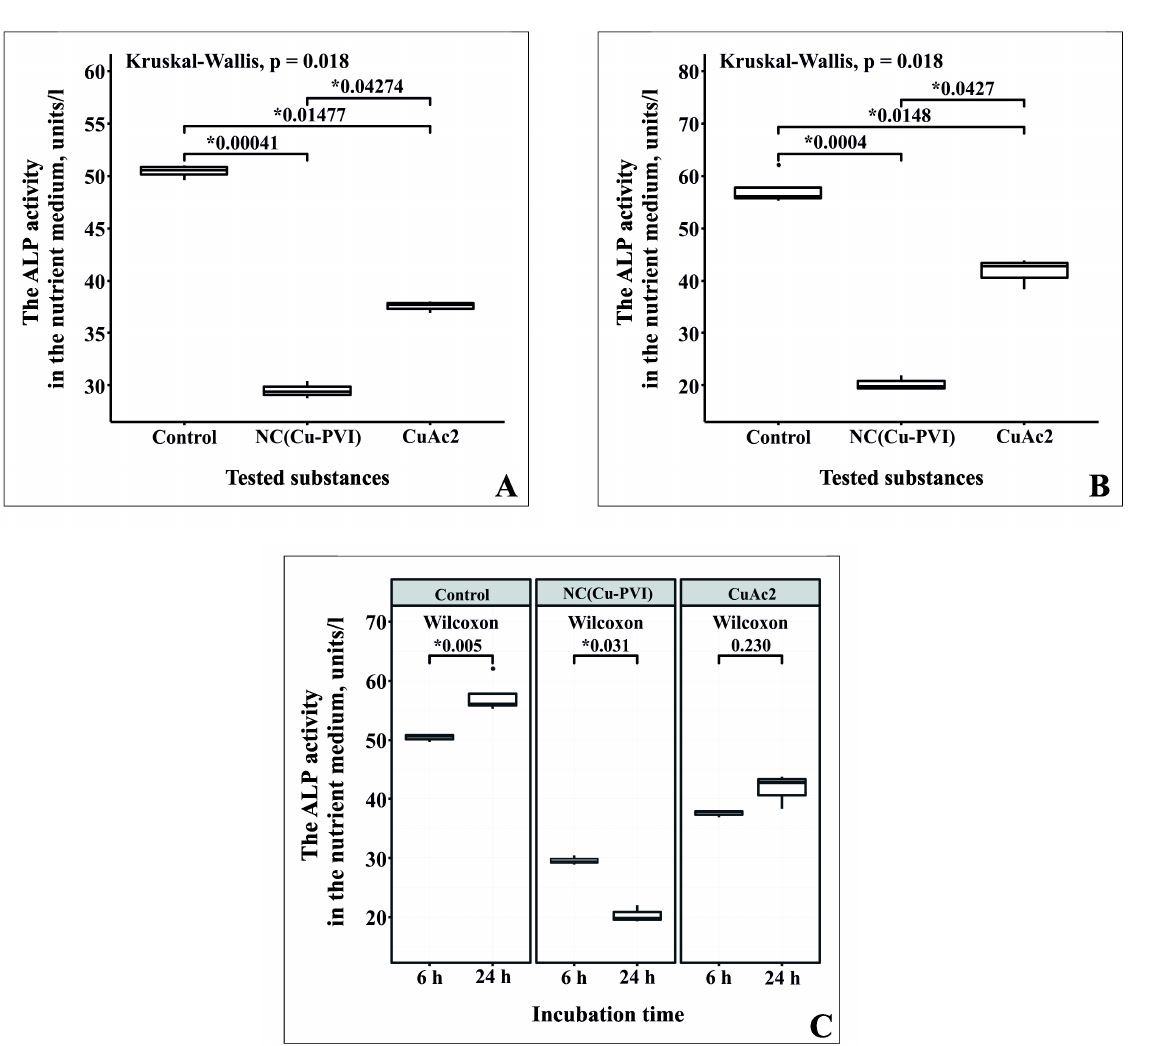
Figure 8. Change in ALP activity in the culture medium after 6 h ( A ) and 24 h ( B ) of incubation with the NC(Cu-PVI) or CuAc 2 in comparison with the control group and depending on the duration of incubation ( C ). Medians and first and third quartiles are shown. * Differences are considered significant at p <